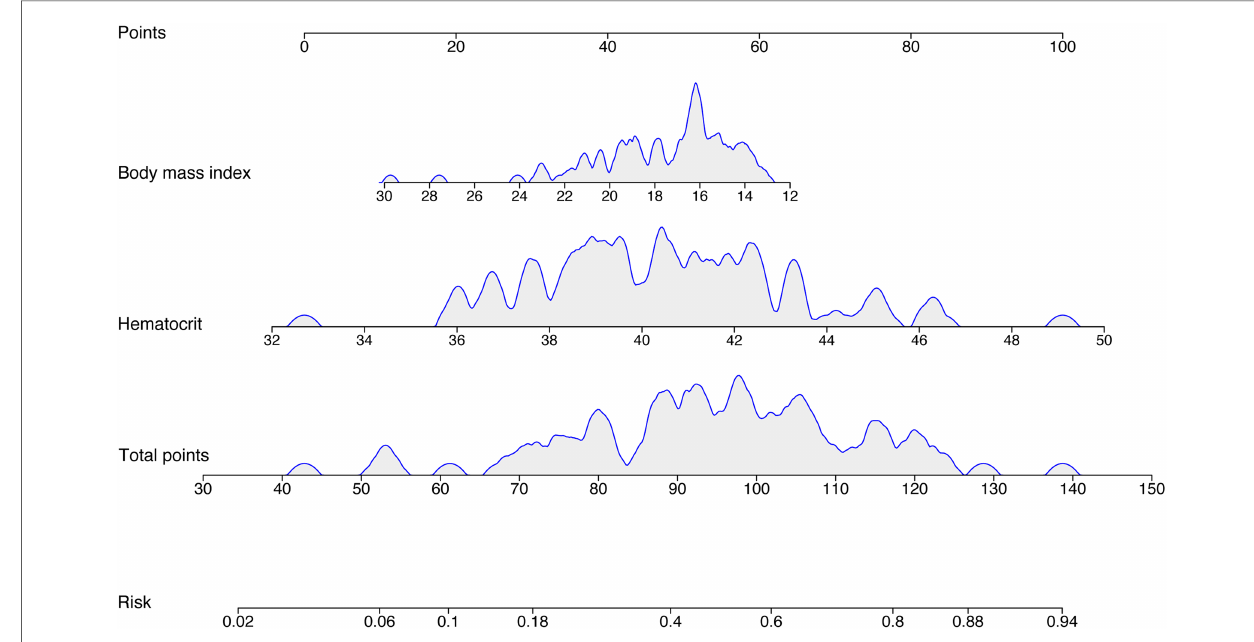
FIGURE 3 Nomogram of the prediction model. The nomogram is applied by placing each patient ’ s items on a variable axis and then drawing a vertical line to determine the points for each item. The total points were then placed on the number axis of the total points line, and a vertical line is drawn to the fi nal